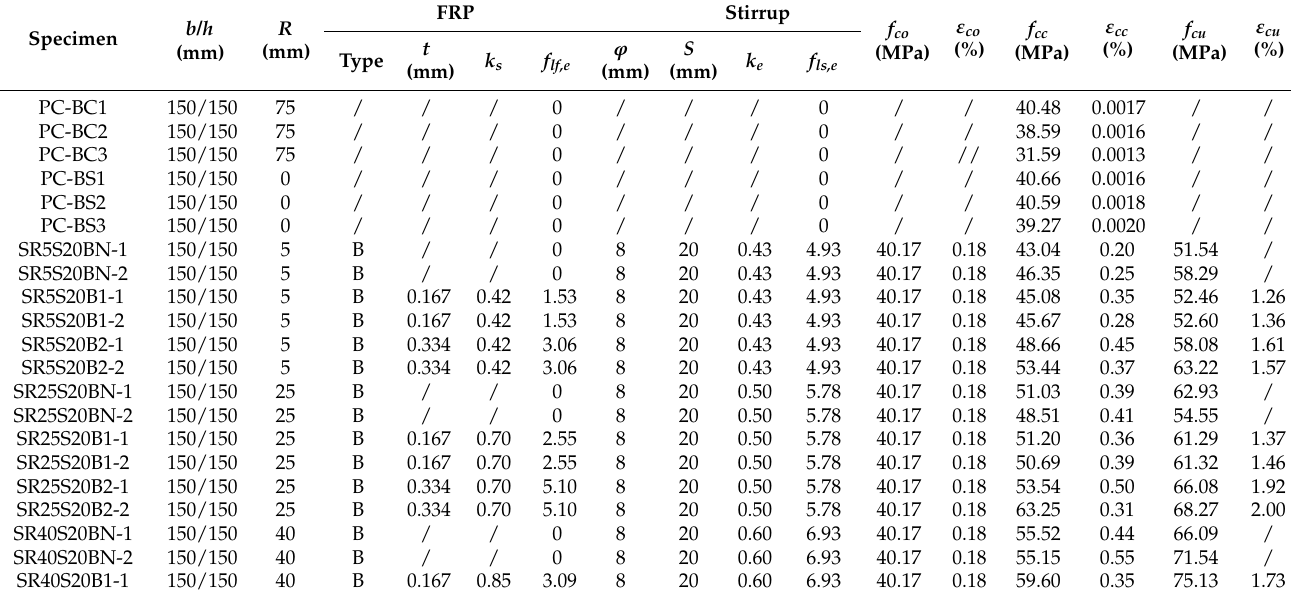
Table 1. Summary of test